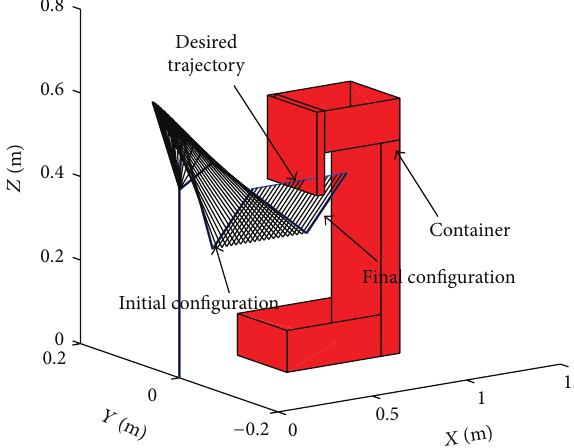
Figure 11: The changes of the position of the end-effector.